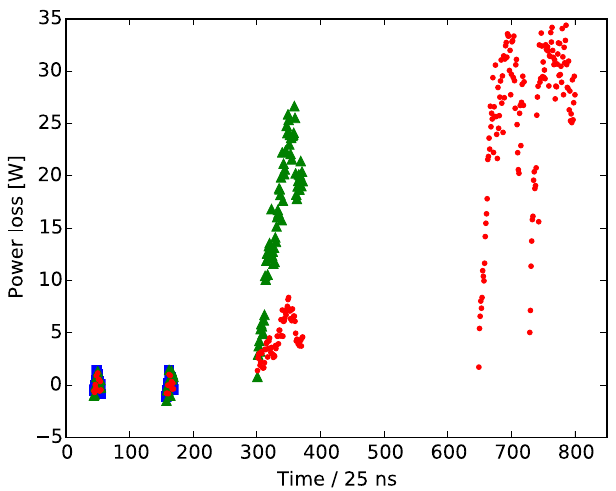
12. Bunch-by-bunch power loss on Beam 1 for a fill with 25 ns beams before the 2012 scrubbing run (Fill 2826, 10-7- 2012) at three different moments: 15 min after the injection of the first trains of 12 bunches (blue squares), a few seconds after the injection of a train of 72 bunches (green triangles), and a few seconds after the injection of two trains of 72 bunches spaced by 225 ns (red circles). The first short bunch train (12 bunches, blue) is used as a reference for the phase shift measurement. N ∼ 1 . 1 × 10 11